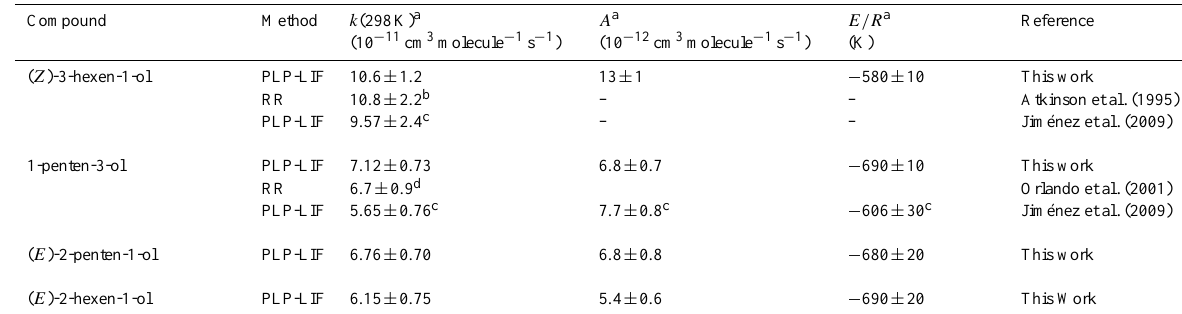
Table 6. Summary of rate coefficients for the OH radical reaction with ( Z )-3-hexen-1-ol, 1-penten-3-ol, ( E )-2-penten-1-ol and ( E )-2-hexen- 1-ol obtained in this work and taken from the